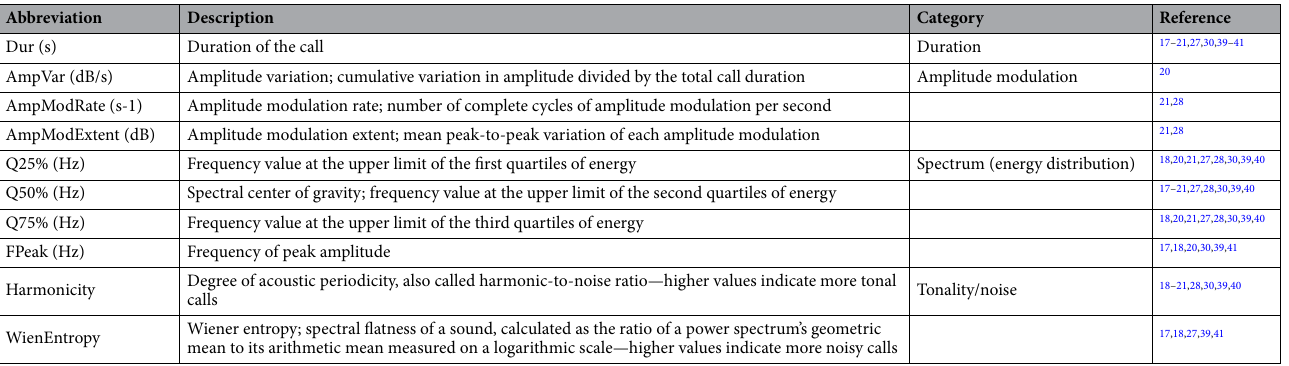
Table 3. Acoustic parameters. Abbreviation and description of the analyzed acoustic parameters, along with the category they were allocated to, which was used to select the best parameters to include in our analyses, as well as examples of references to other studies where these parameters were measured in relation to emotions in pig and wild